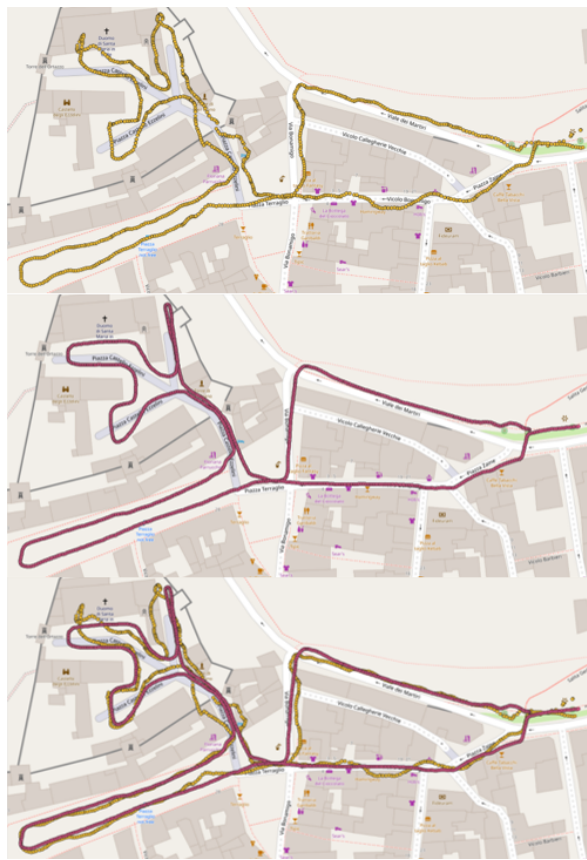
Figure 4: Trajectory provided by mobile phone (top), after bundle adjustment (middle), and comparison (bottom).